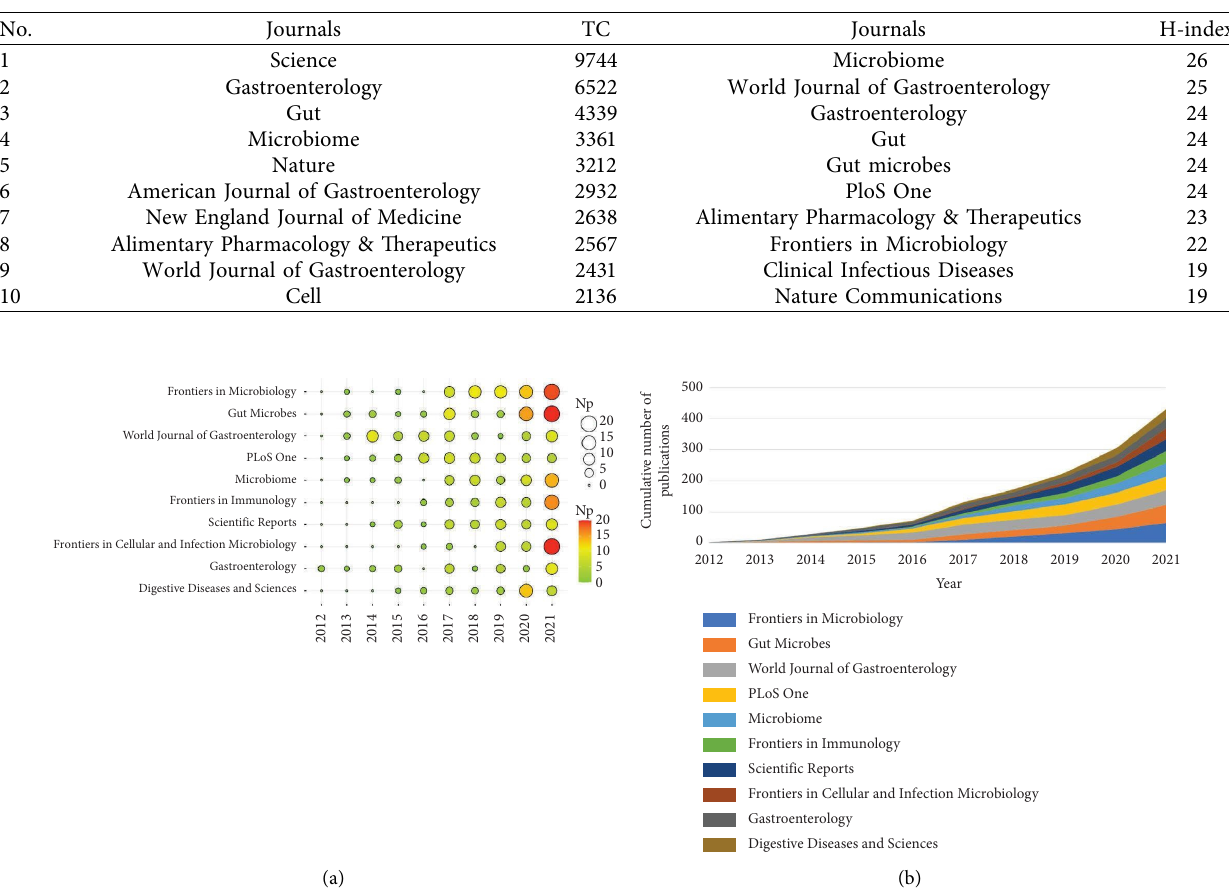
Table 2: Te top 10 high-impact journals in FMT research.